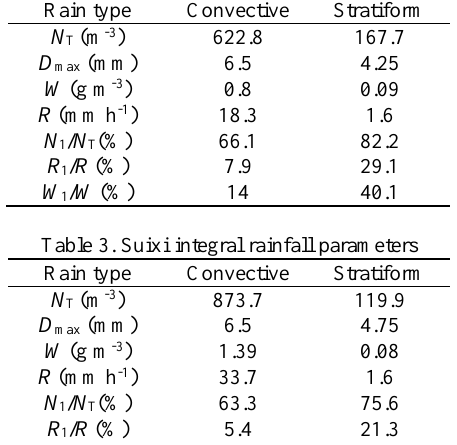
Figure 3. Average raindrop spectra in Zhanjiang and Suixi Table 2 and 3 show integral microphysical parameters of rain. N 1 , R 1 , W 1 indicate integral parameters caused by particles smaller than 1 mm. In total number concentration and water content, convective precipitation is much larger than stratiform precipitation. The total concentration of convective precipitation in Zhanjiang and Suixi is 622.8 and 873.7 m -3 respectively. The corresponding stratiform is 167.7 and 119.9 m -3 . The water content was 0.8 g m -3 (Zhanjiang convection) and 1.39 g m -3 (Suixi convective), 0.09 g m -3 (Zhanjiang stratiform) and 0.08 g m -3 (Suixi stratiform). Table 2. Zhanjiang integral rainfall parameters